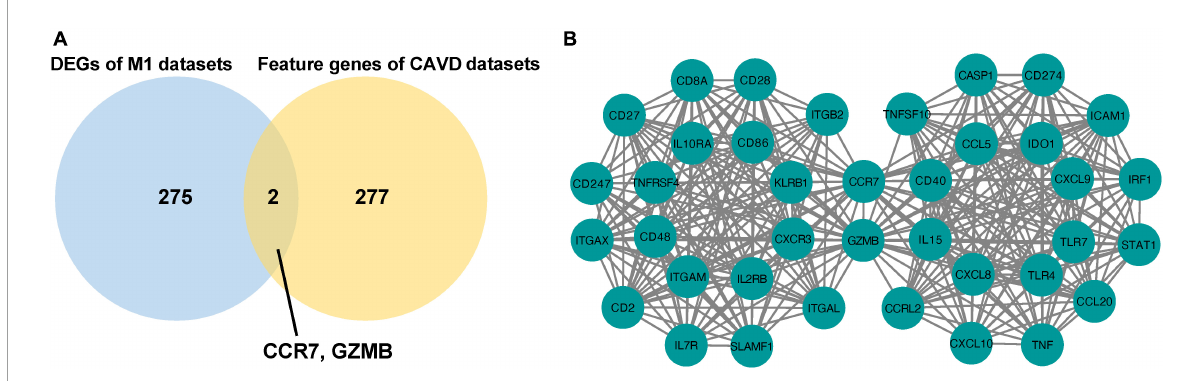
FIGURE7 Identification of shared genes between M1-polarized and CAVD datasets. (A) Venn diagram of the shared genes in M1-polarized and CAVD datasets. (B) The interaction between 40 hub genes in M1-polarized and CAVD datasets.